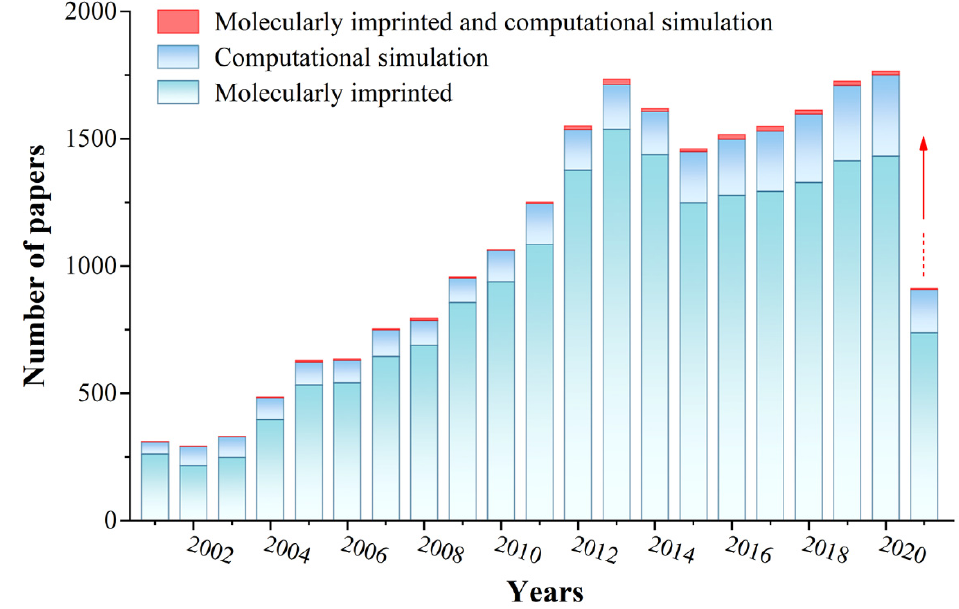
Figure 2. The literature statistics of MIPs and computational simulation. (Database: Scifinder; Search keywords: molecularly imprinted, computational simulation, molecularly imprinted and computational simulation, respectively. Search time: 13 June 2021).